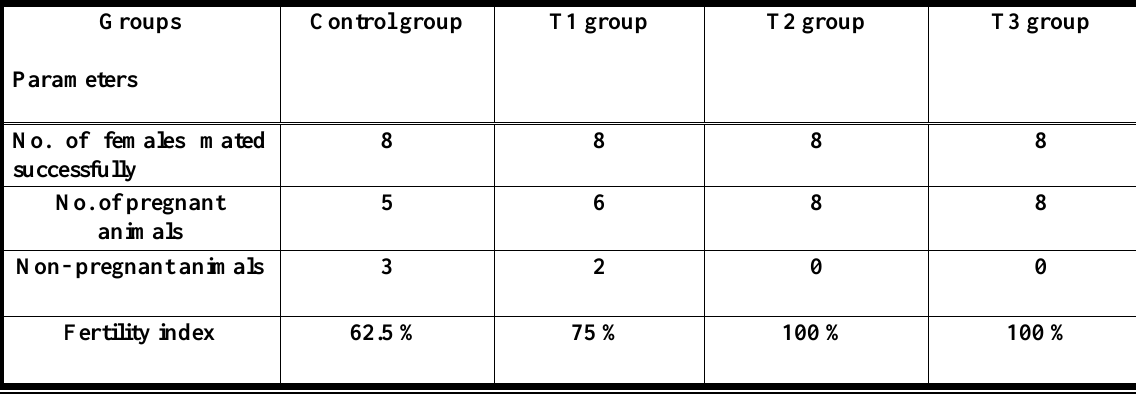
Table (3): Effect of date palm pollen (DPP) on fertility index (%) in non treated female rats.(n=8/group ).